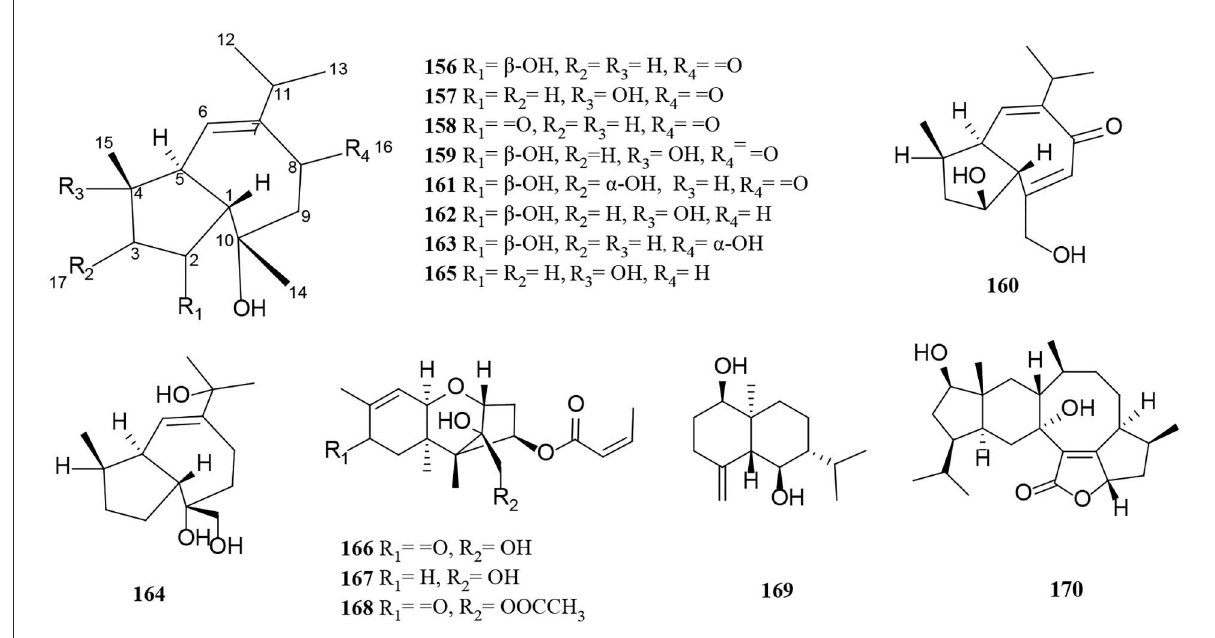
FIGURE10 Sesquiterpene derivatives ( 156 – 170 ) from Alternaria